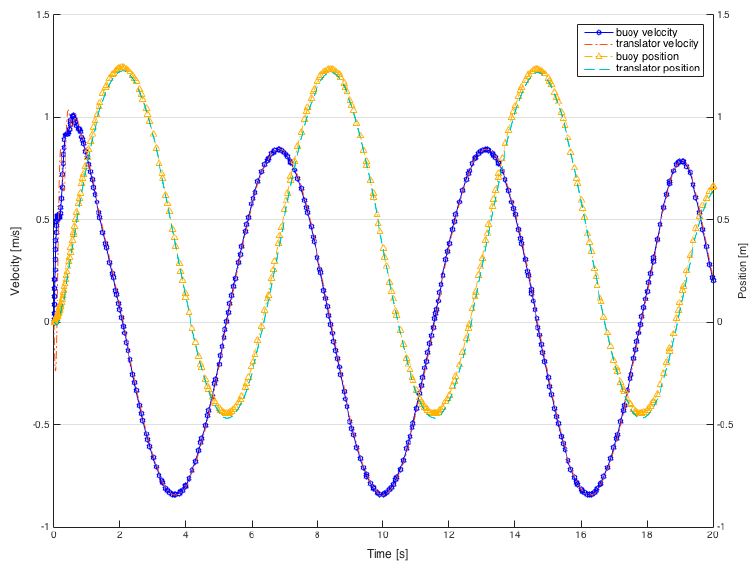
Figure 2. A solution example from the numerical model of differential Equation (1). In this case, the amplitude of the harmonic wave is 1 m and the period is 6 s with a sampling time of 0.1 s. The WEC is modeled with a translator mass of 5000 kg and a constant damping coefficient of 60 (kN ∙ s/m).